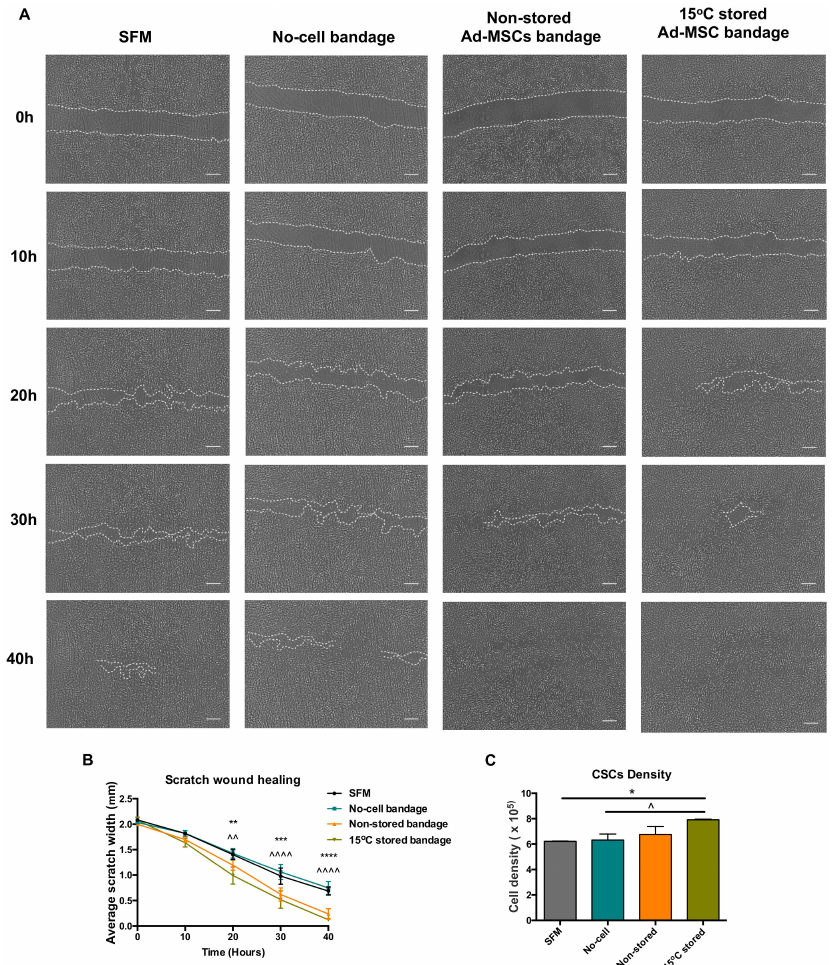
Figure 2. Wound closure analysis. ( A ) Representative images of scratch wound closure at times 0, 20, and 40 h taken using Iprasense holographic microscope, ( B ) average scratch width, and ( C ) corneal stromal cells (CSC) cell density following wound closure taken using Alamar blue assay of non-stored. Scale bar = 300 µ m. Values are presented as mean ± SEM from three separate corneal stromal cells donors, and asterisks represent significance between SFM and 15 ◦ C stored Ad-MSCs bandages, whereas symbols represent significance between no-cell bandages and 15 ◦ C-stored Ad-MSCs bandages (**** / ˆˆˆˆ, p < 0.0001; ***, p < 0.001; ** / ˆˆ, p < 0.01; * / ˆ, p < 0.05). SFM, Serum-free media; no-cell bandages, alginate bandages formed without Ad-MSCs; non-stored bandage, bandages used immediately following formation; and 15 ◦ C stored bandages, bandages used following 72 h